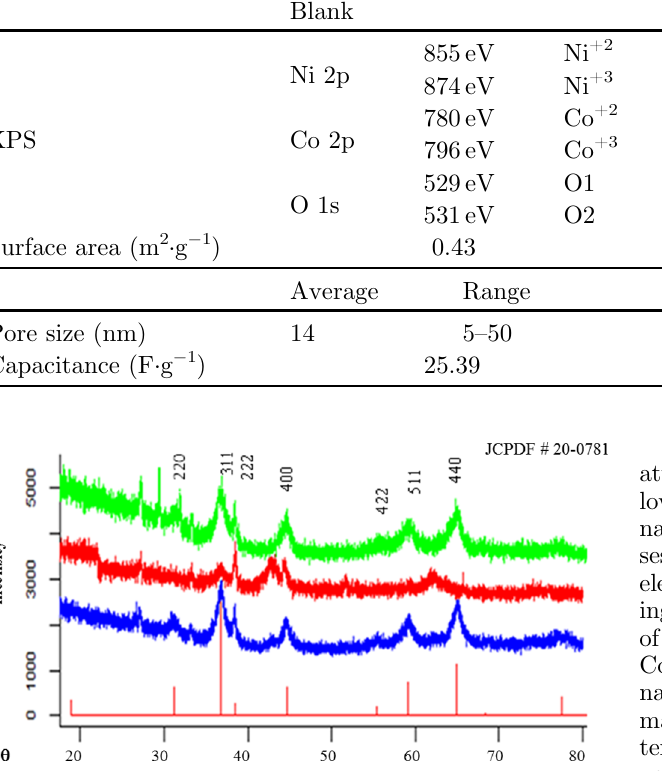
Fig. 1. XRD patterns for NiCo 2 O 4 blank (blue), ESM templated (red), PMMA templated